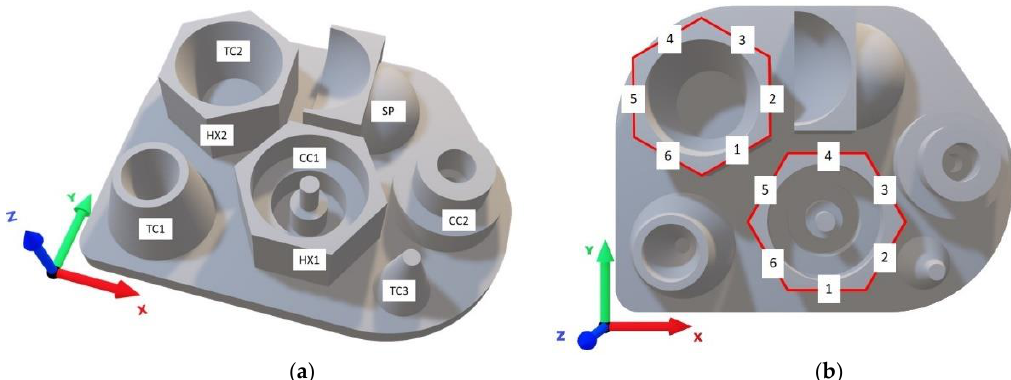
Figure 2. The test artifact designed for the experiment. ( a ) The computer-aided design (CAD) model with labeled features in perspective; ( b ) top view of the CAD model showing the numbering of planes in HX1 and HX2.